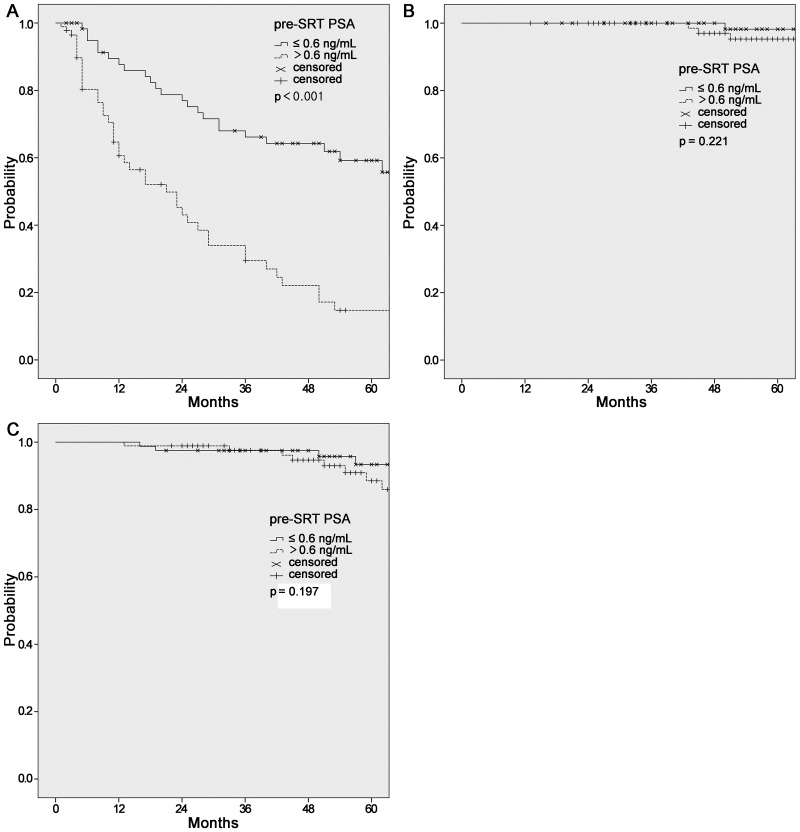
Kaplan–Meier estimates of biochemical progression-free survival (BCPFS, A), cause-specific survival (CSS, B), and overall survial (OS, C) according to preSRT PSA level.